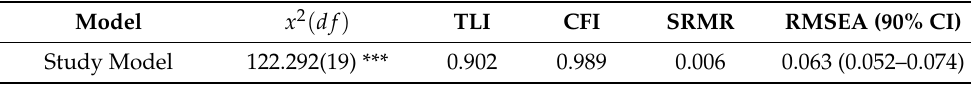
Figure 4. Final study models. Table 7. The goodness of fit of the study